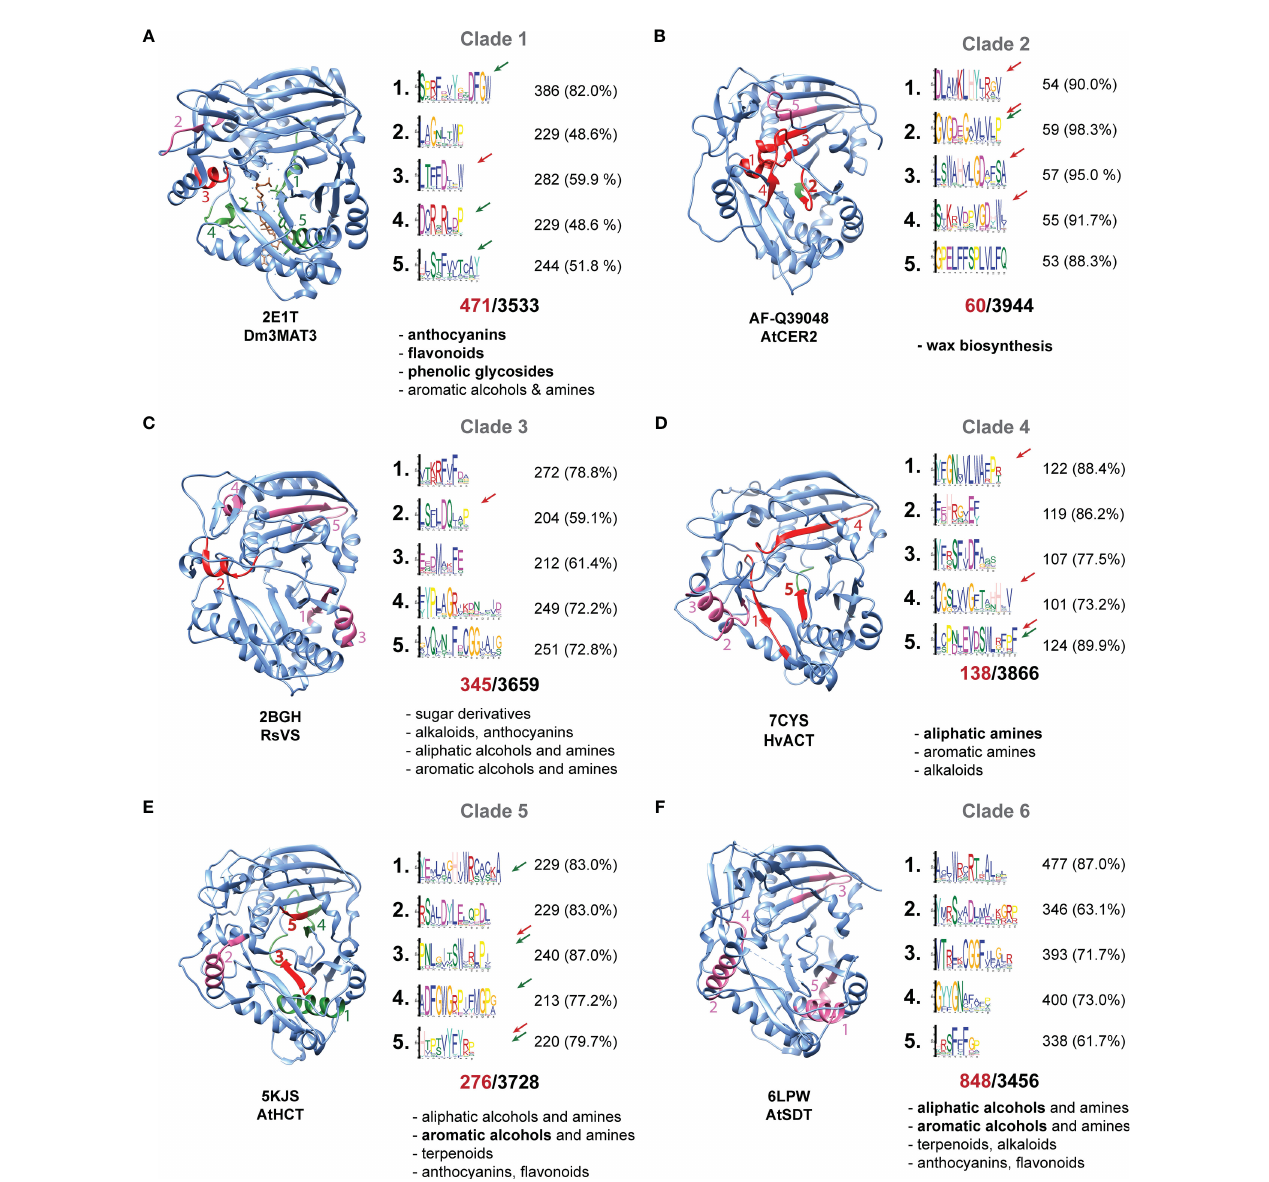
FIGURE 3 Clade-speci fi c enriched motifs. (A – F) Motifs that are enriched in the sequences in the OGs of the respective clade, in comparison to all other OGs identi fi ed across 52 representative plant genomes. Motifs were identi fi ed using STREME in discriminatory mode. Only the top 5 enriched motifs are shown, and their locations on the protein structures are highlighted. Clade 6 motif locations are best guesses since some motifs are not found in AtSDT. Each protein structure is positioned with the acceptor binding pocket in the foreground and donor CoA binding pocket in the back. Motifs that are exposed to the acceptor side are highlighted with a red arrow and colored red within the structure. Motifs exposed to the donor side indicated are indicated with a green arrow and colored green. Structural motifs are colored in pink. For each clade, the number in red below the motifs indicates the number of sequences found in the corresponding OGS of that clade, and the black number indicates the number of sequences used as background. The number and percentage of sequences with the motif are given for each motif. All known substrate classes of each clade are noted, according to the nomenclature introduced in Kruse et al., 2022, with the most typical structural class